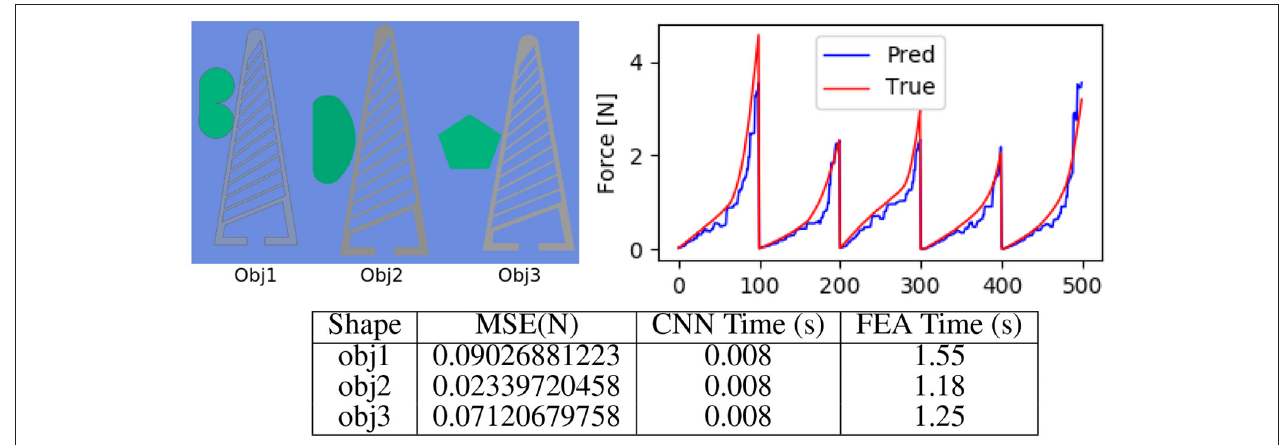
FIGURE 6 | Evaluating shape generalisation. (Top left) The three objects with different shape profiles, used for evaluating the approach. (Top right) Force ( F x ) predicted by our approach as compared to the true forces computed using FEA. (Bottom) We quantitatively evaluate the mean squared error in the force, which is under 0.1 N. It can be seen that the prediction time by our approach is 0.008s, which makes it suitable for real time control. For FEA we compute the mean time over 100 Frames on a workstation with i5 (6th generation) 8 GB RAM, 256 GB SSD Windows 10 machine running ANSYS 19.3. Note that the systems used for